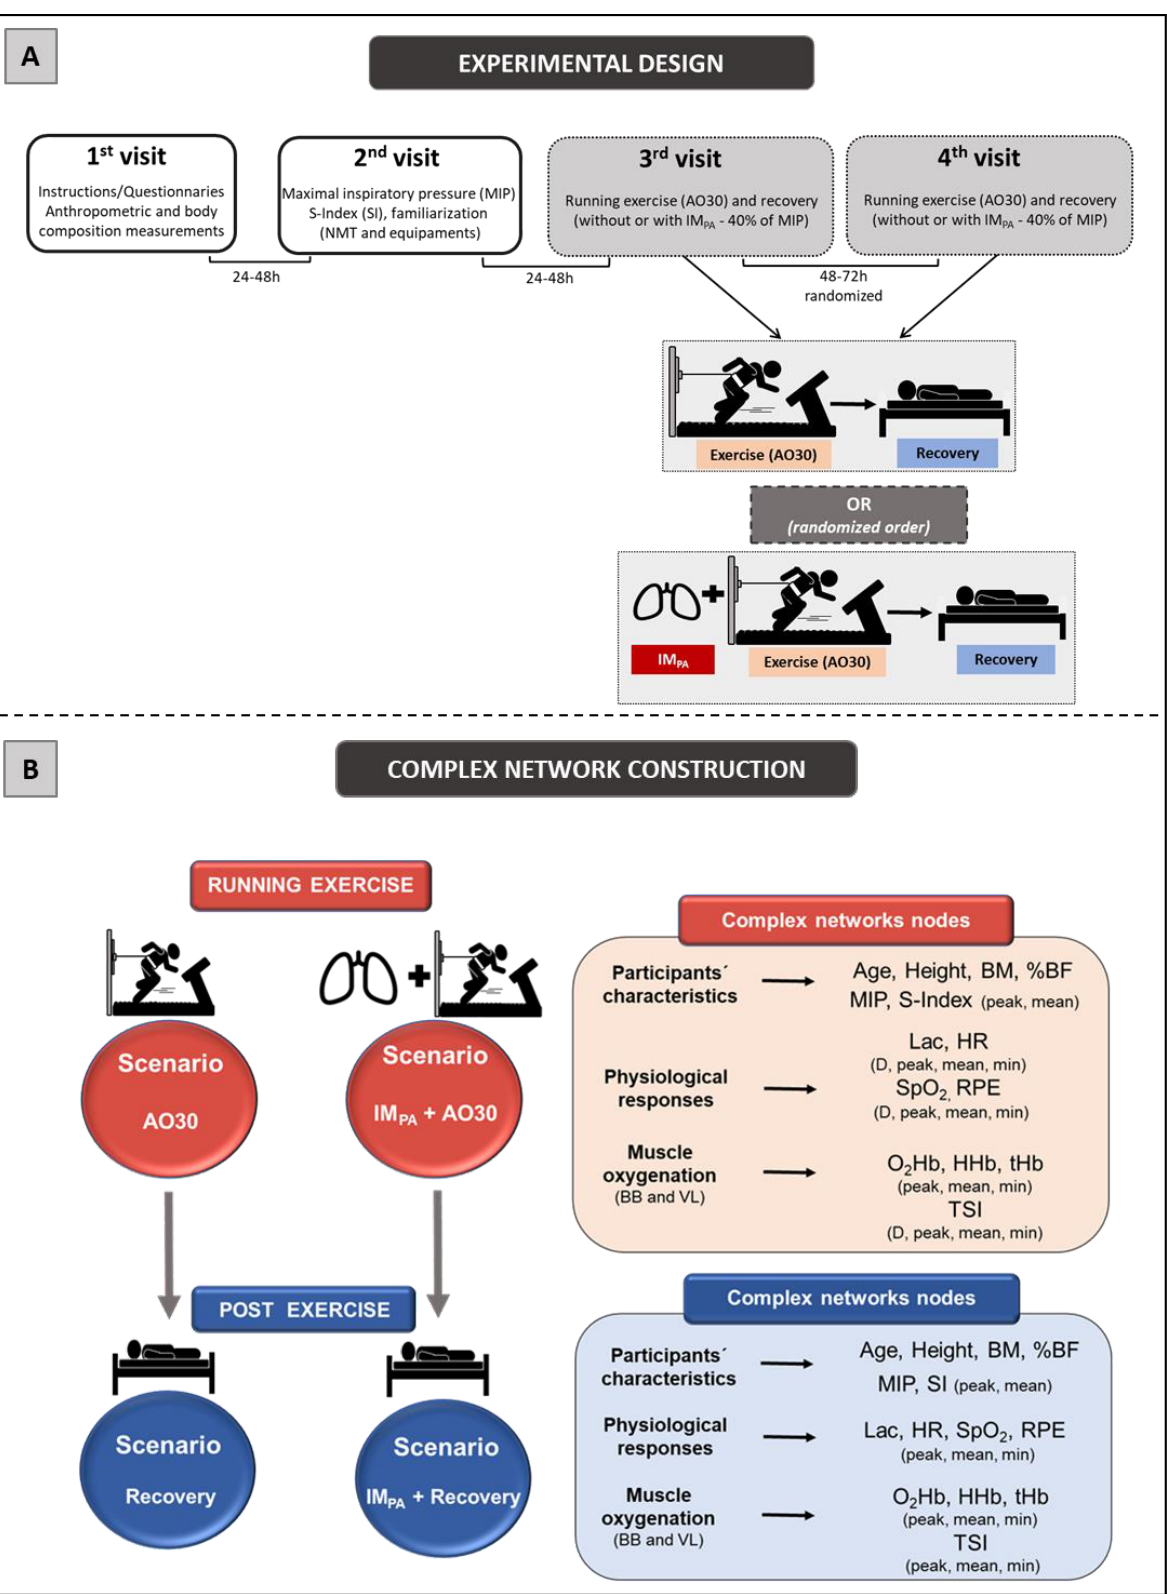
Figure 1. Panel A. Experimental design . First and second visits were conducted for sample characterization and familiarization. Additionally, the maximal inspiratory pressure (MIP) and global strength index